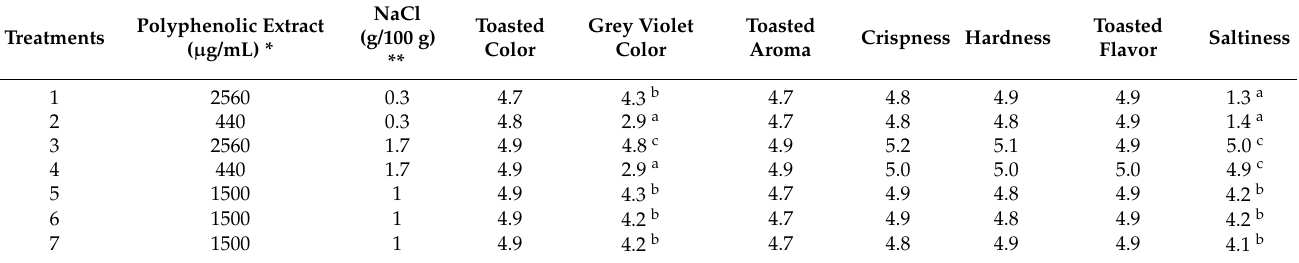
Table 4. Descriptive profile of crackers added with different amounts of red Tara pods extract and NaCl.